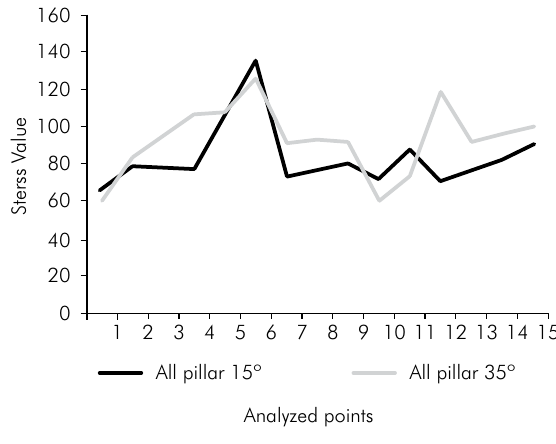
Graph 2. Stress behavior for points analyzed per group for load in the last pillar.